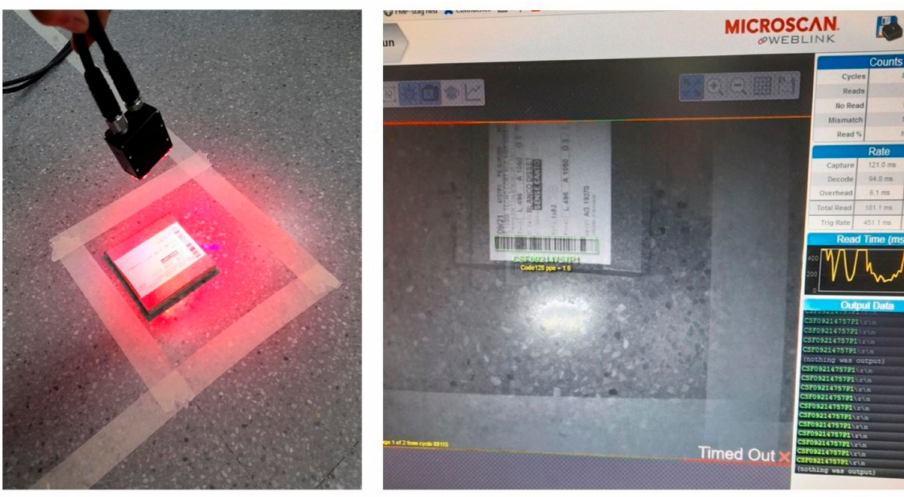
Figure 6. Experimentation of scale and variation and training of the camera